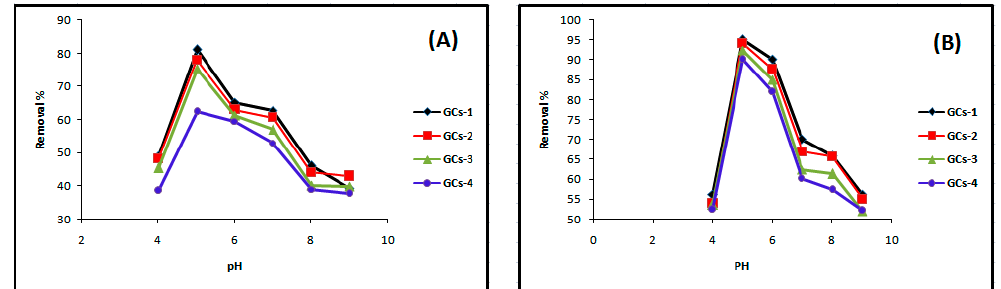
Figure 3. Influence of pH on ( A ) nickel and ( B ) copper sorption.